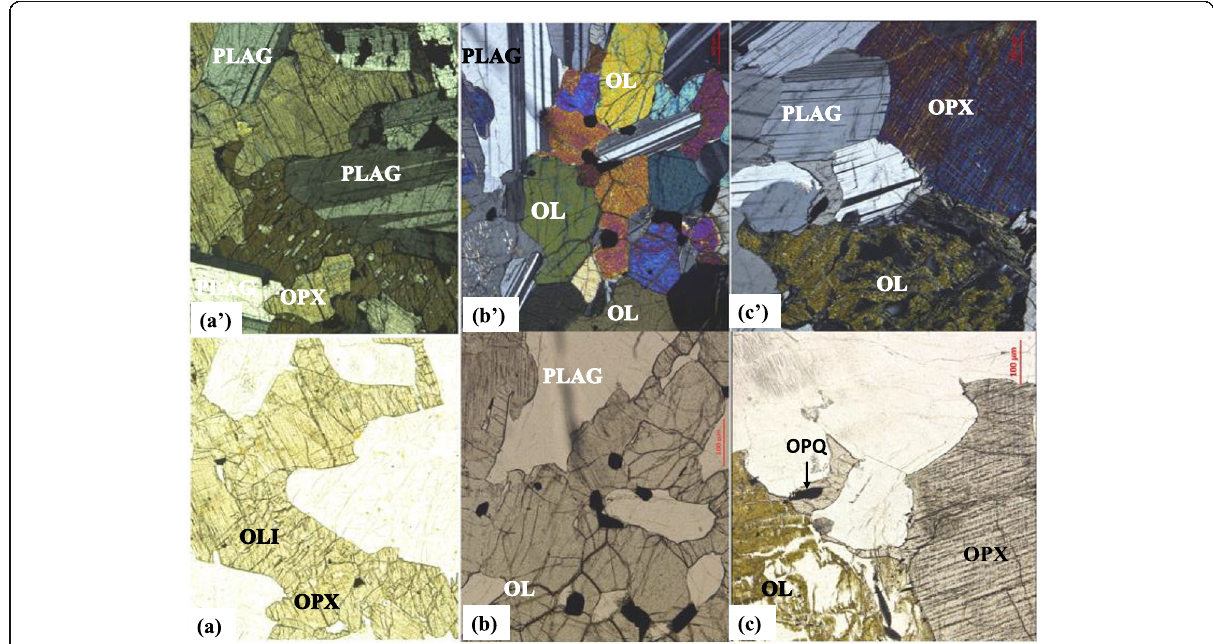
Fig. 4 Thin sections of the rock types underlying the landslide areas (Magnification: X5). a - a ” norite (Charlotte); ( b - b ’ ) Olivine gabbro (Regent); ( c - c ’ ) Olivine gabbro (Madina). The top images are under cross-polarization, whilst the bottom ones are under plane polarization. OL: Olivine; OLI: Olivine with cracks and plagioclase inclusions; OPX: Pyroxene; Opq: Opaque minerals; PLAG: